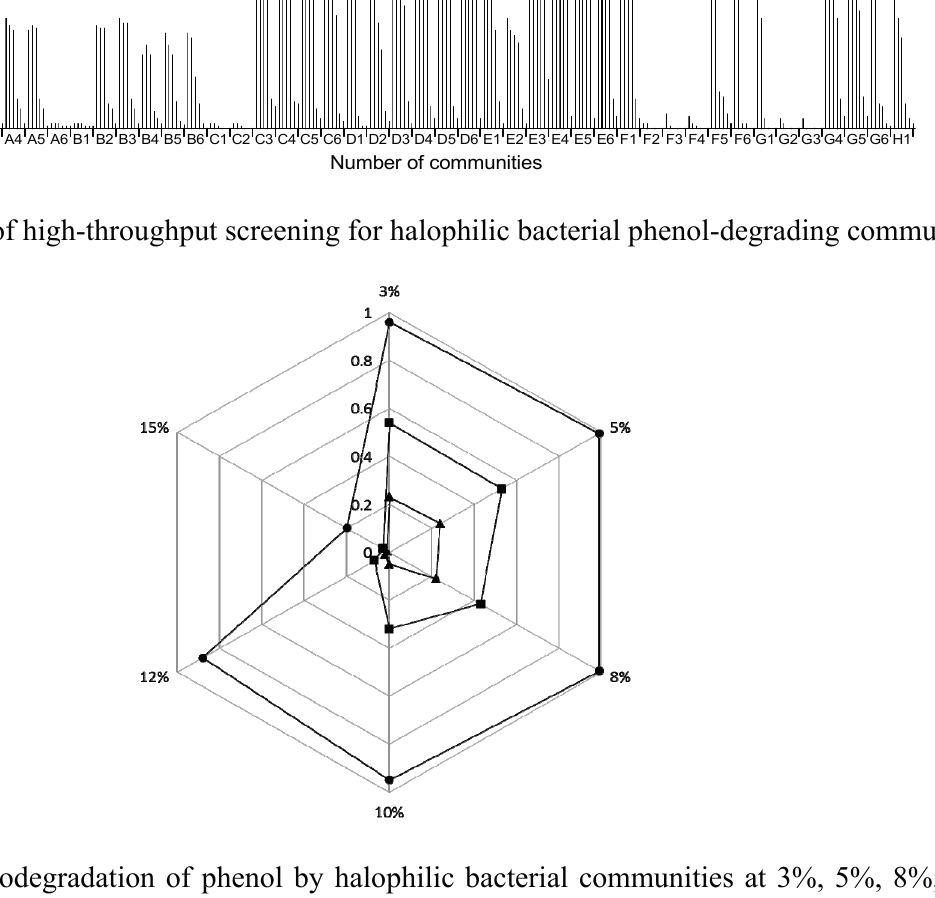
Figure 4. Biodegradation of phenol by halophilic bacterial communities at 3%, 5%, 8%, 10%, 12%, 15% NaCl ( w / v ); ● : E3, ■ : D2, ▲ :